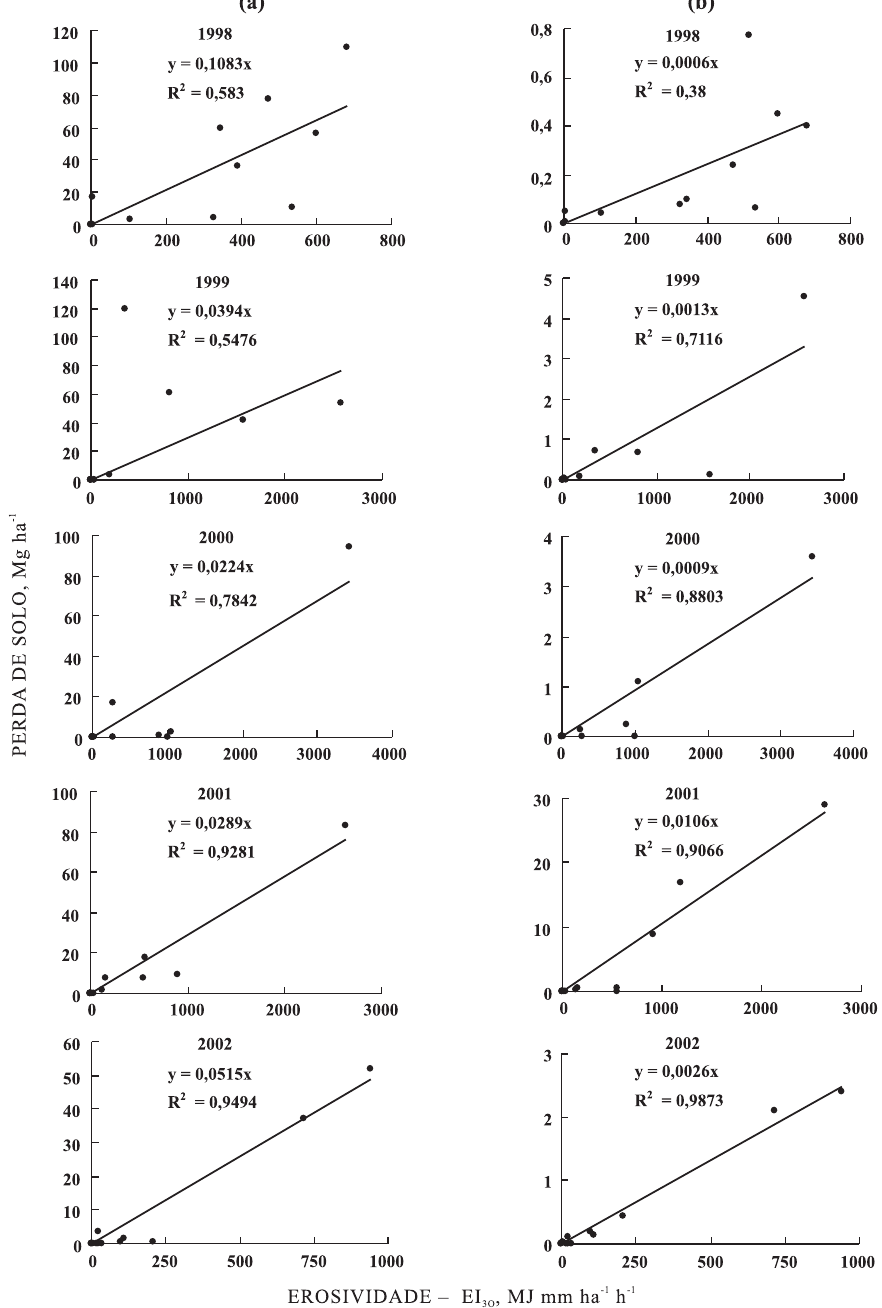
Figura 1. Regressão linear entre erosividade – EI (Fator R) das chuvas e perdas de solo em A) Cambissolo 30 Háplico Tb distrófico típico e em B) Latossolo Vermelho distroférrico típico, sob chuva natural, em Lavras (MG), durante um período de cinco